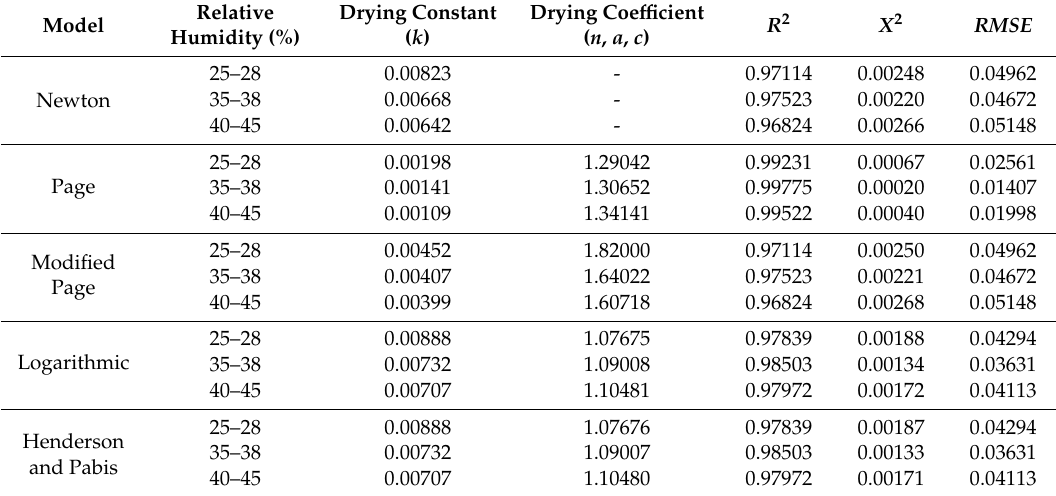
Table 5. Summary of the regression analysis of apple slices at 50 ◦ C and air flow velocity of 1.1 m / s and three ranges of ambient relative